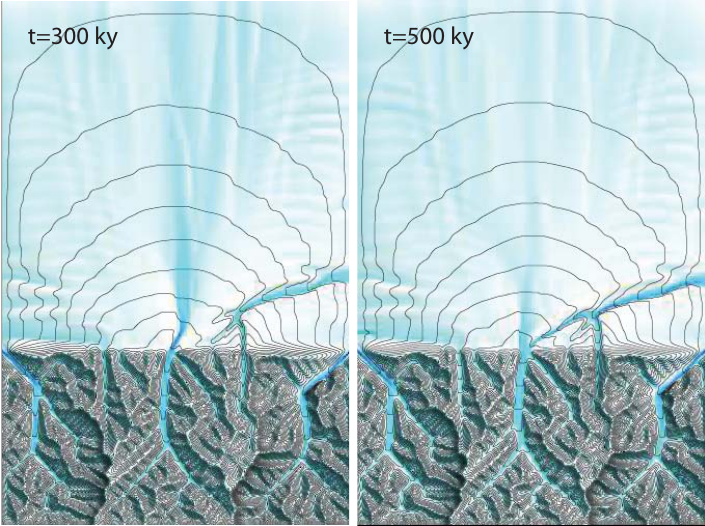
Figure 8. Experiment 4a, the incised stream first connects through headward incision to the secondary river (left, t = 300kyr) before being connected to the outlet of the central river at the end of the experiment (right, t = 500kyr).